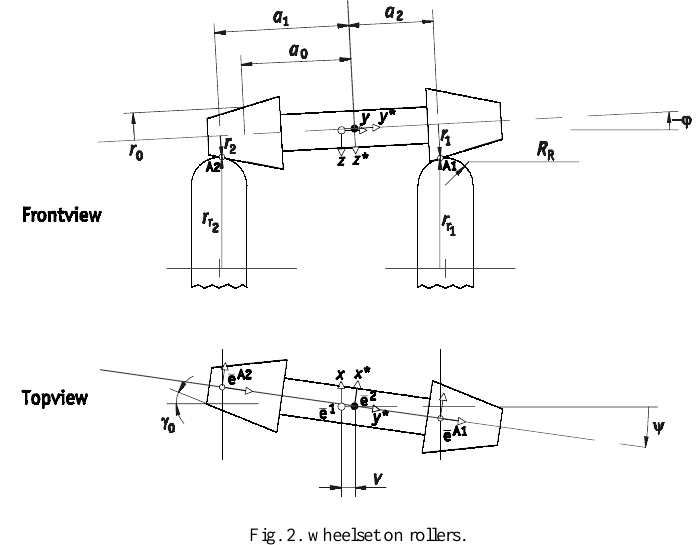
Fig. 2. wheelset on